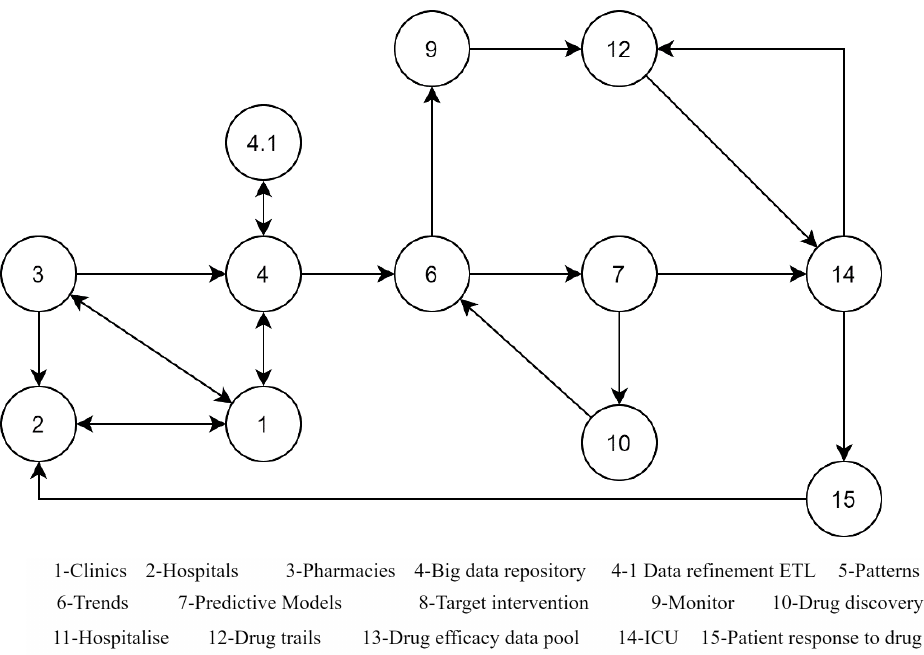
Figure 3. Flowchart for drug discovery in pandemic situation using big